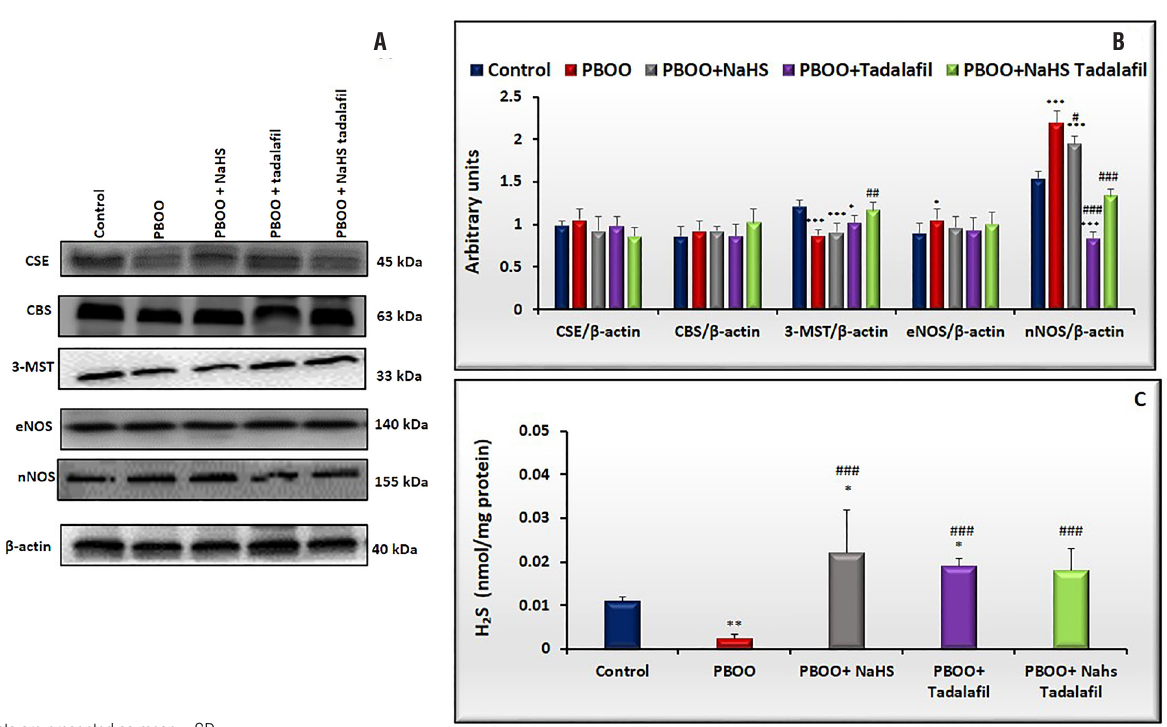
Data are presented as mean ±